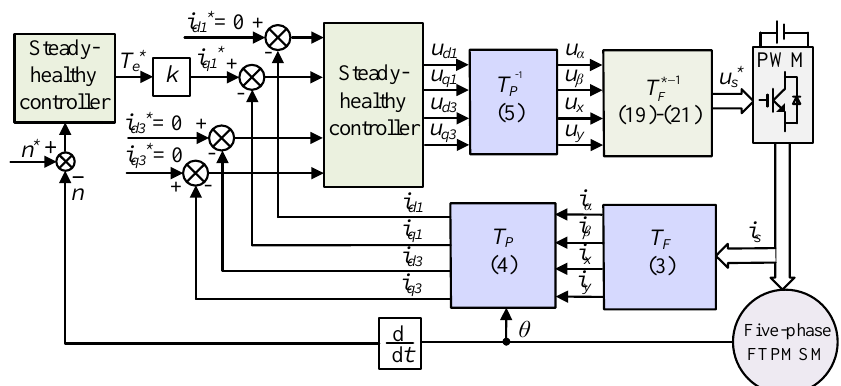
Figure 4. Block diagram of the fault-tolerant FOC drive system for five-phase FTPMSM based on disturbance adaption.